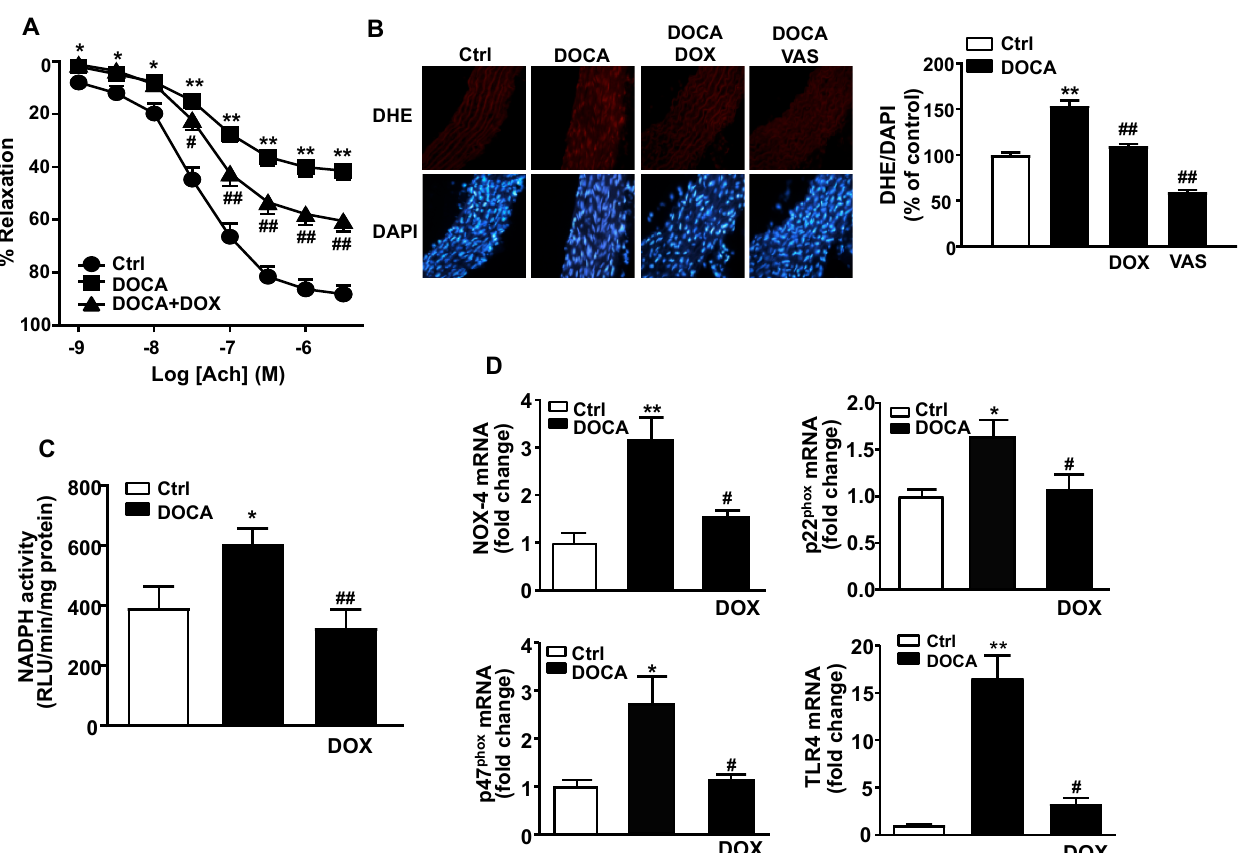
Figure 5. Effects of Doxycycline (DOX) on endothelial function, vascular oxidative stress and NOX pathway. ( A ) Endothelial reactivity to acetylcholine (Ach) in aortas precontracted with phenylephrine in control (Ctrl) and DOCA-salt groups. ( B ) Top images display arteries incubated with dihydroethidium (DHE), which produces a red fluorescence when oxidized to ethidium by ROS. Bottom images depict the blue fluorescence of the nuclear dye DAPI (original magnification, × 400). Averaged values ( n = 8 rings from different rats) of the red ethidium fluorescence normalized to the blue DAPI fluorescence. ( C ) NADPH oxidase activity measured by lucigenin-ECL and ( D ) Expression of NADPH oxidase subunits NOX-4 and p22 phox and Toll-like receptor (TLR)4 at the level of mRNA by RT_PCR in Ctrl and DOCA-salt rats. Data are represented as means ± SEM ( n = 8). * p < 0.05, ** p < 0.01 versus Ctrl group; # p < 0.05, ## p < 0.01 versus nontreated DOCA group.